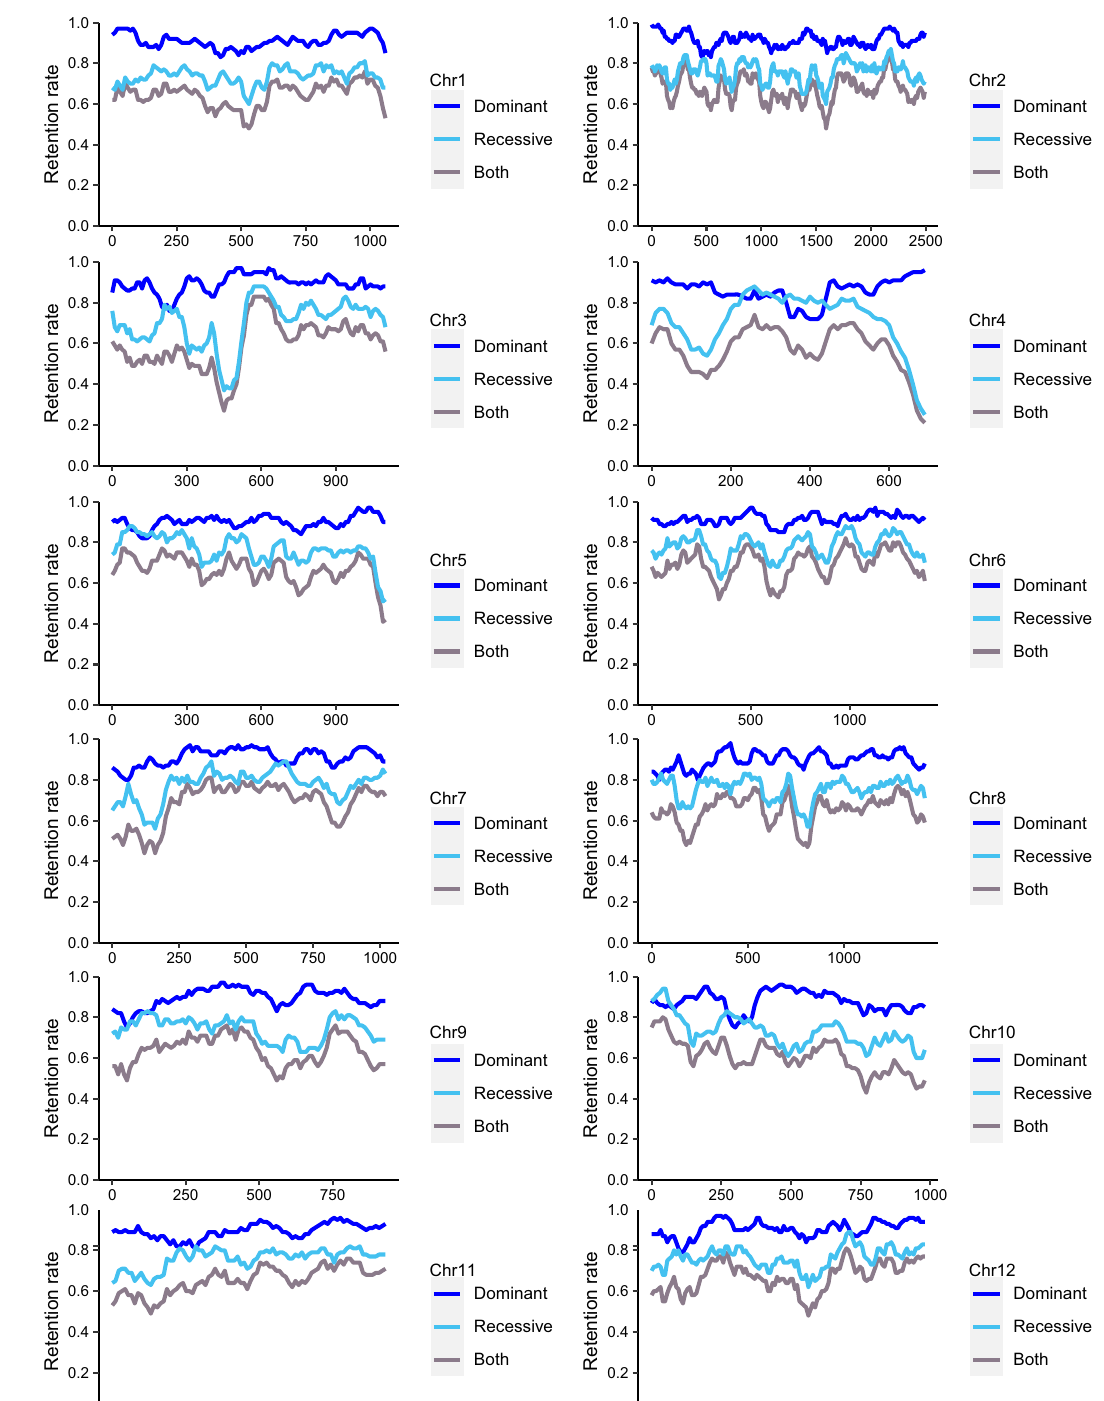
Fig. 6 | Fractionation pattern on the dominant and recessive subgenome of Rhoiptelea chiliantha , using Quercus lobata as the target genome. The X axis indicatesgenelocationsalongeach Q.lobata chromosome,andtheYaxisindicates the proportion of orthologous syntenic genes retained (retention rate) in R. chi- liantha dominant subgenome (blue), recessive subgenome (cyan) and both